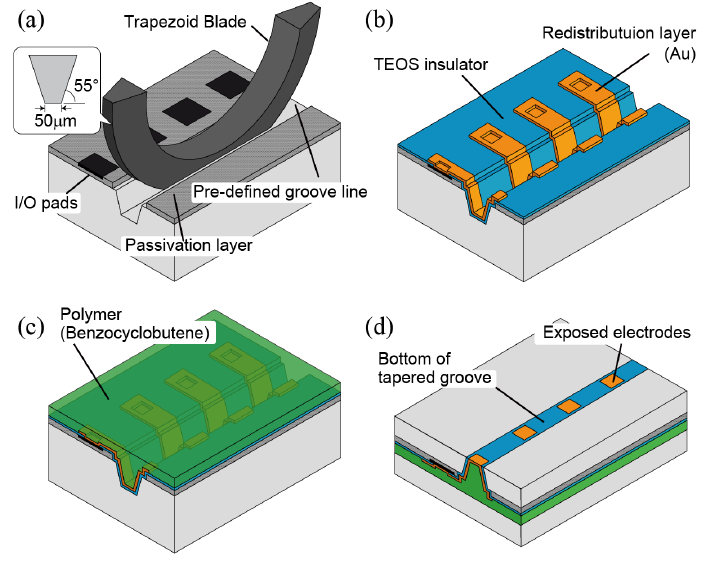
Figure 4. Procedure of the through silicon groove (TSG) technology: ( a ) groove forming; ( b ) insulation and rewiring of I/O pad into groove; ( c ) groove filling with polymer and planarization; ( d ) back